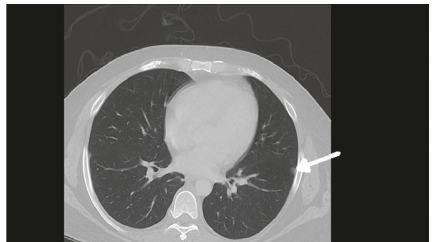
Figure 2: CT imaging showing multiple irregular pulmonary nodules (arrow) at different levels. The morphology of these nodules favors infectious/inflammatory nodules more than ma- lignancy. Vasculitis can also have this appearance.